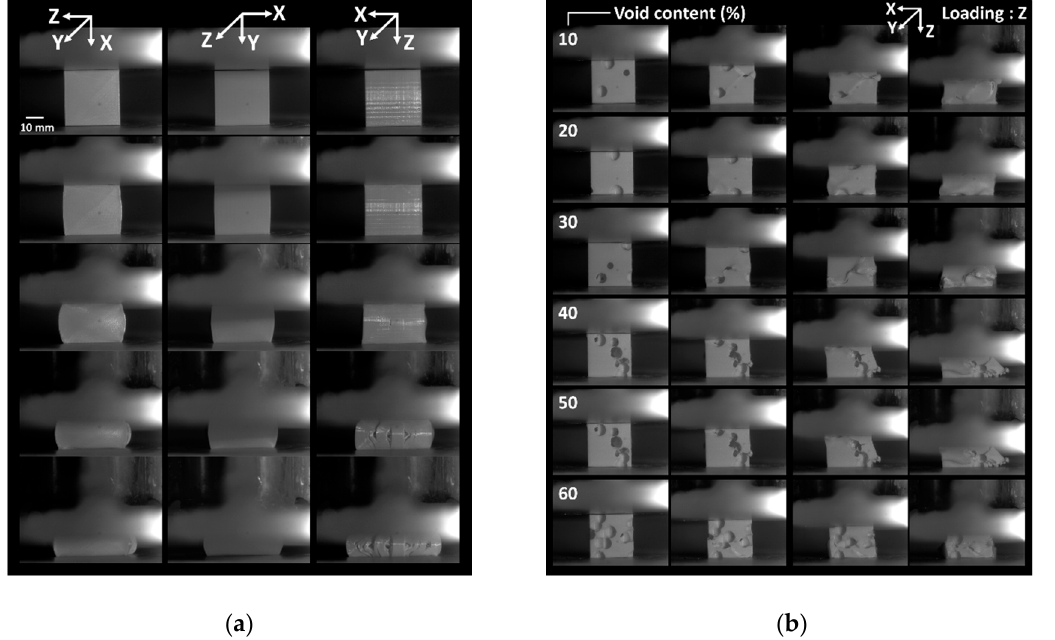
Figure 1. Compression results of airy printed Polylactic Acid (PLA) structures: ( a ) compression sequence of dense PLA printed structures in different loading directions. Z is the building direction, ( b ) deformation sequences as a function of the porosity content of three-dimensional (3D) printed cellular PLA. Loading is performed in Z-direction.